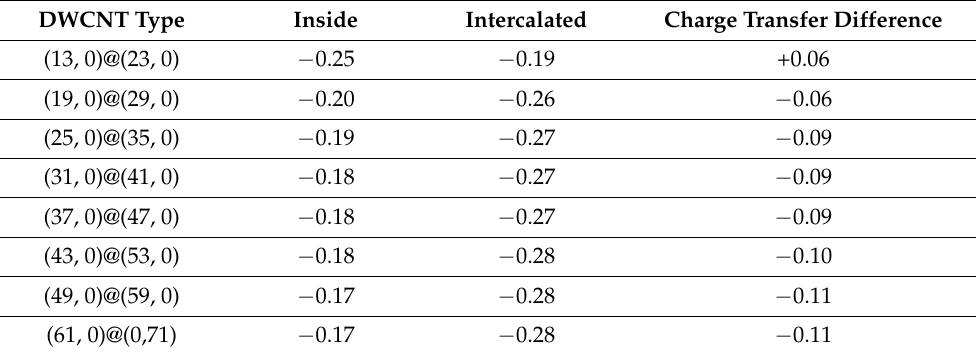
Table 2. DFT-D2 computed charge transfer (electrons per iodine atom) for inside and intercalated configuration for iodine in zigzag ( n , 0)@( n + 10, 0) DWCNTs. Negative number indicates charge transfer from the tube to the iodine